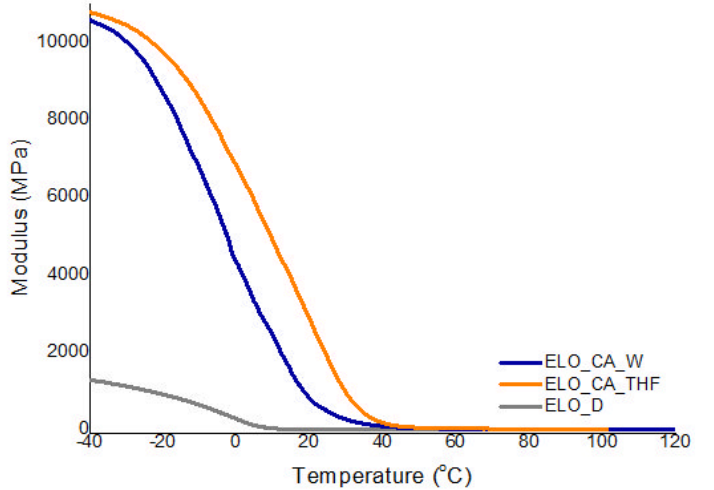
Figure 6. Variation of the storage modulus with the temperature for the ELO ‐ based matrices.